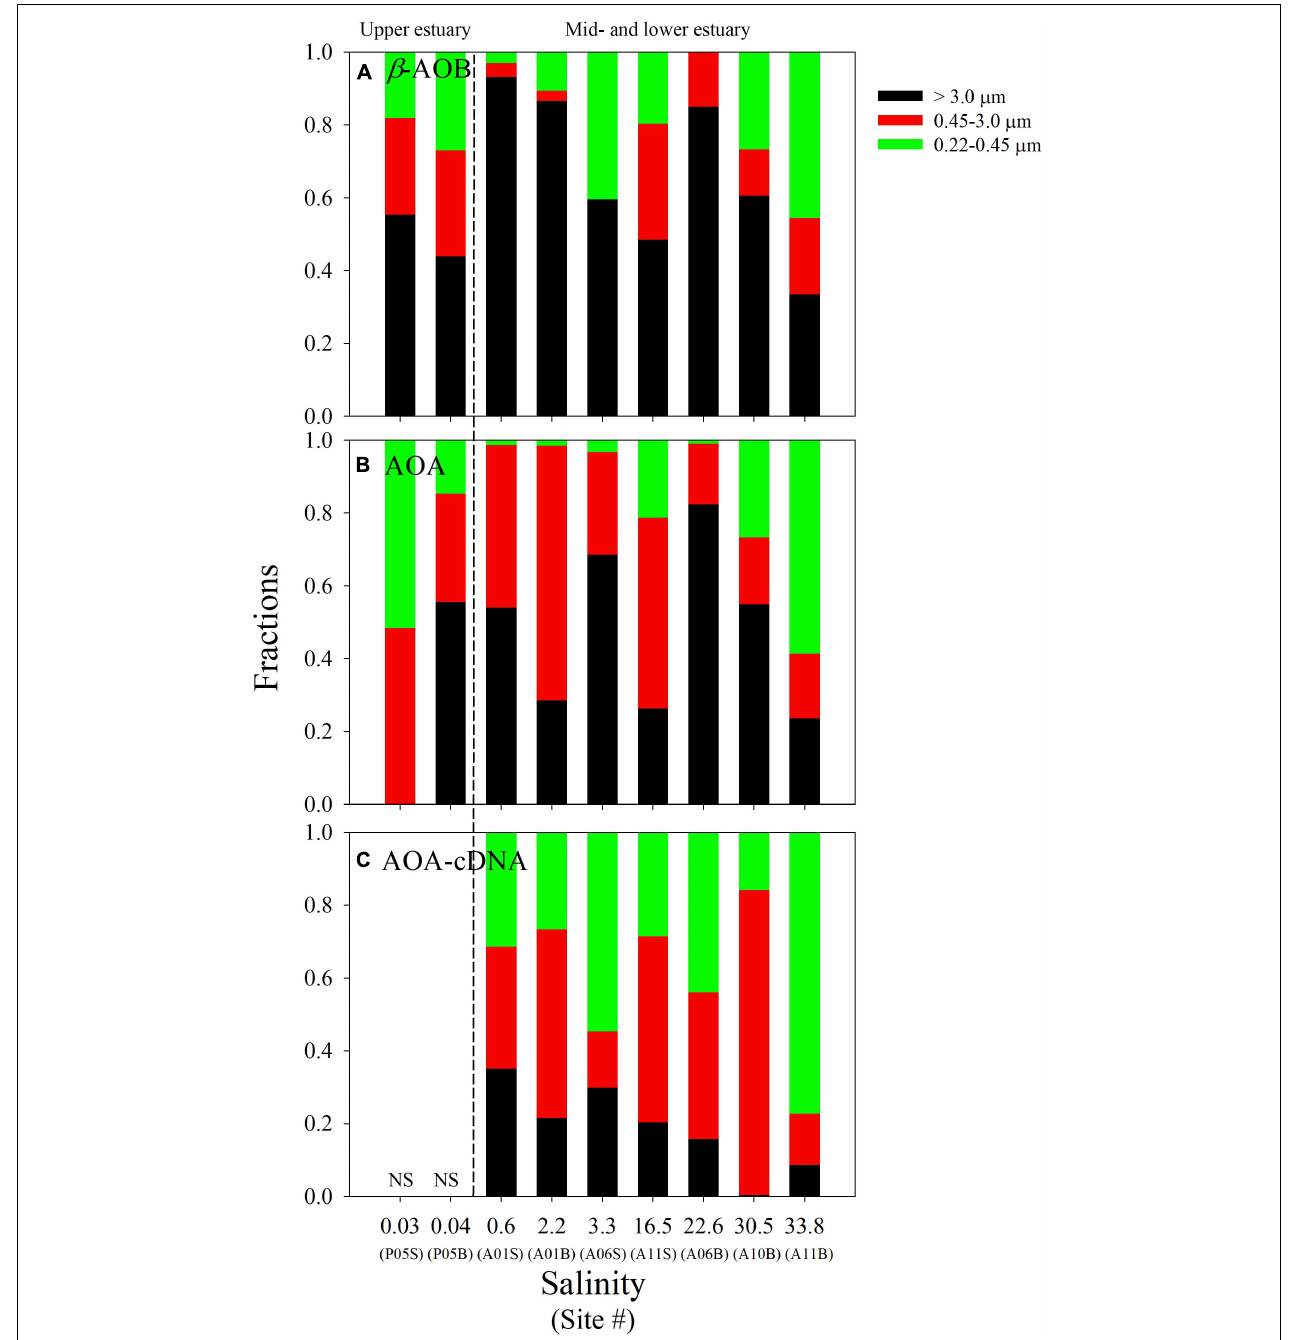
FIGURE 4 | Relative abundance of the DNA-based amo A genes of β -AOB (A) and AOA (B) on the different size fractions along the salinity gradient in the PRE. In addition, the relative abundance of the cDNA-based amo A genes of AOA (C) on the different size fractions are also shown. The dashed line separates the study sites into the upper estuarine region, and the mid- and lower estuarine regions. The suffixes “S” and “B” of site information represent the surface and bottom samples at each site, respectively. The detailed data are presented in Supplementary Table 4 .